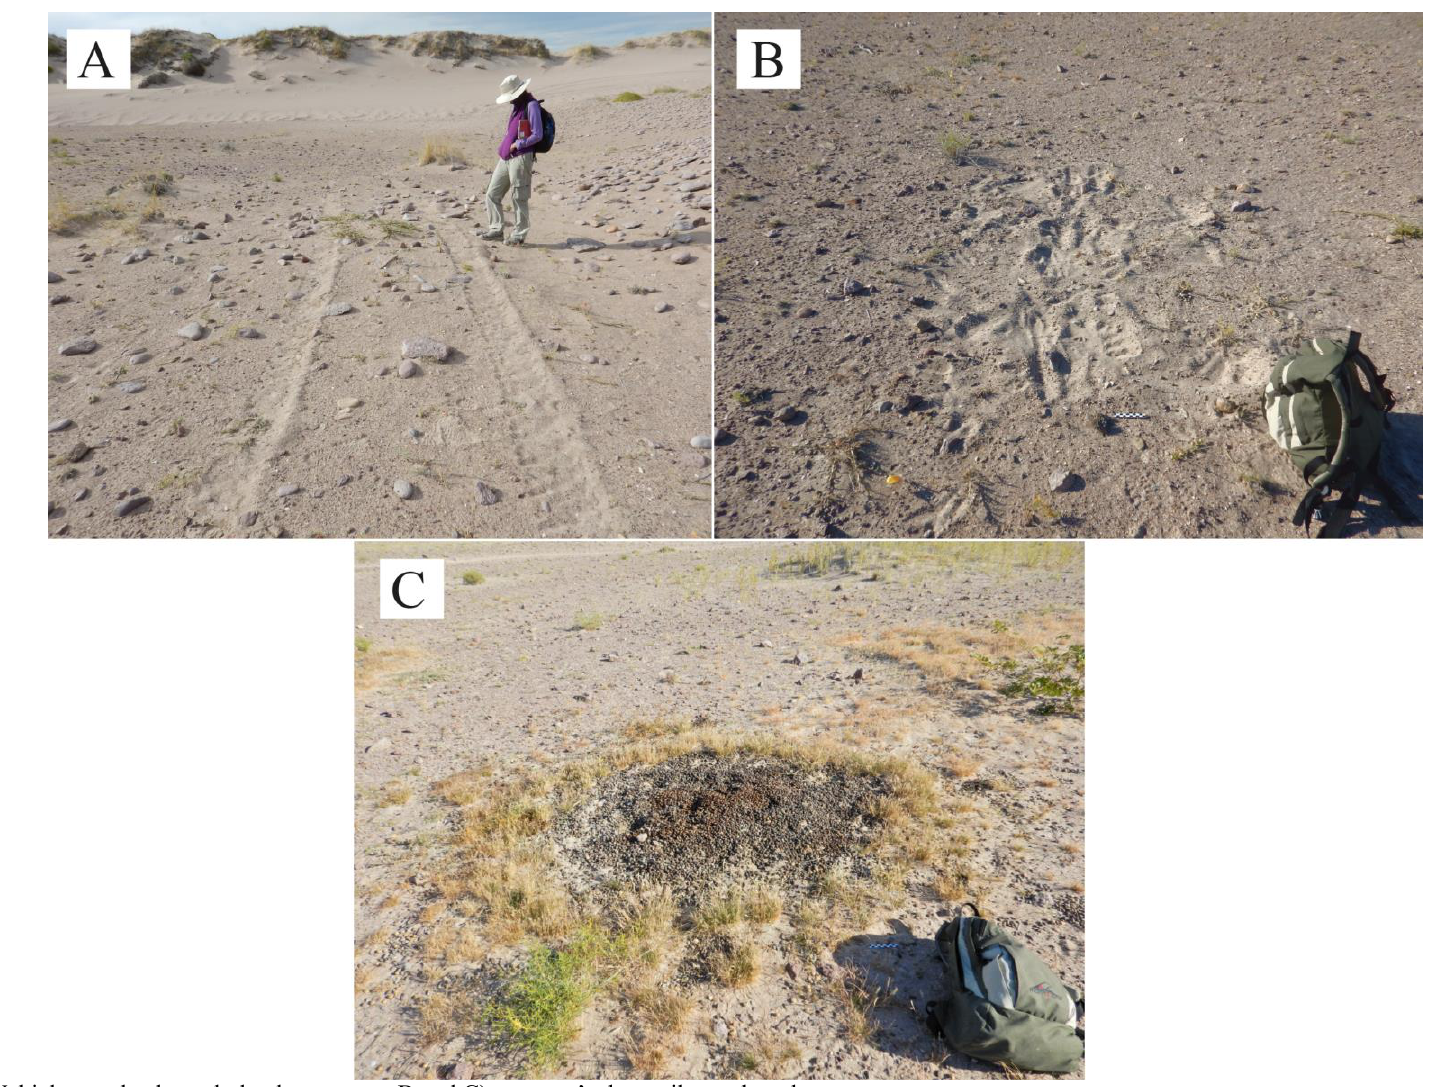
Figure 2. A) Vehicles tracks through the dune sector; B and C) guanaco’s dung piles and